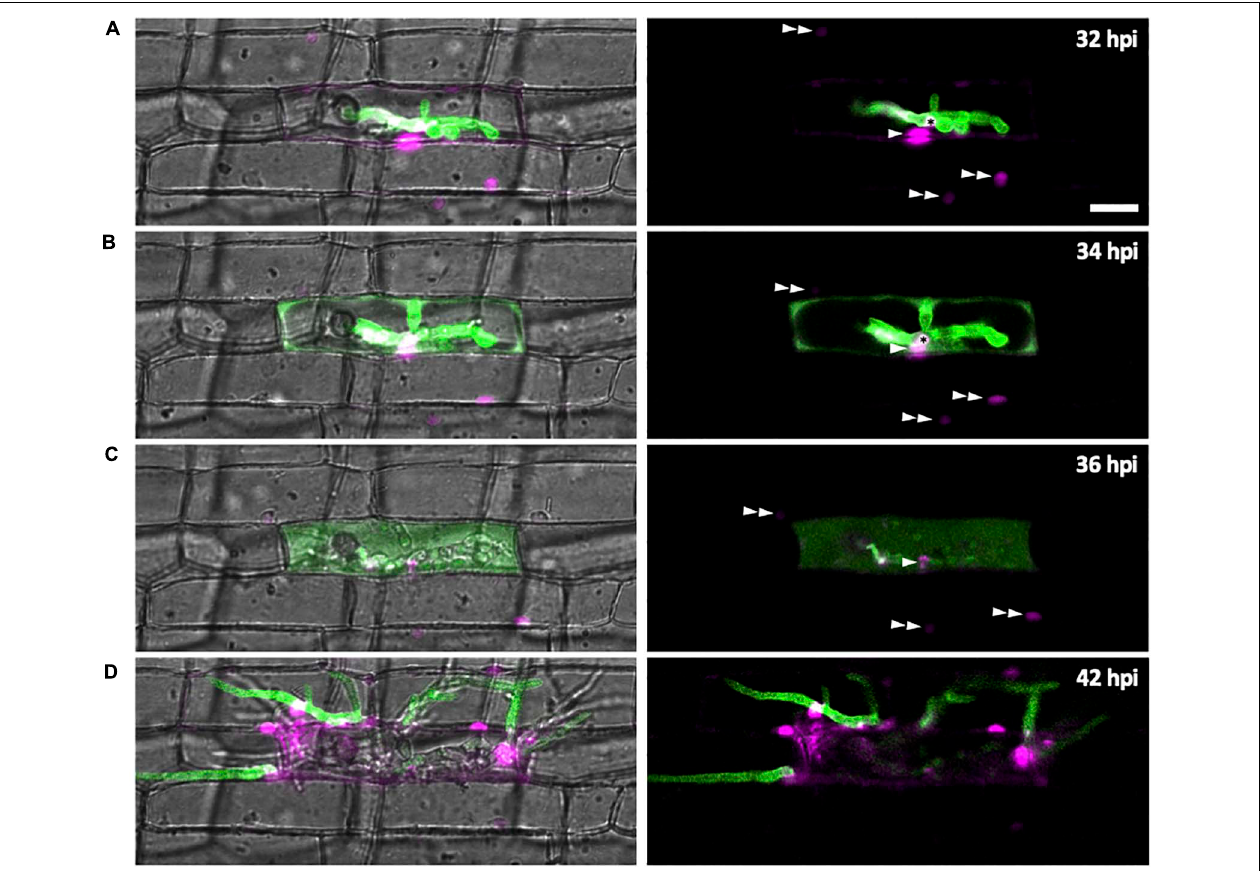
FIGURE 7 | Effector localization changes during invasion of the first few host cells. M. oryzae CKF1616 expressing apoplastic effector Bas4:EGFP (green) along with cytoplasmic effector Pwl2:mCherry:NLS (magenta) invading rice. Shown are single plane merged fluorescence and bright-field (left panels), and merged fluorescence alone (right panels) confocal images of a time-lapse series from 32 to 42 hpi. Asterisk = BIC. Single white arrowhead = first-invaded host cell nucleus with Pwl2:mCherry:NLS fluorescence. Double white arrowhead = nuclei of uninvaded host cells with Pwl2:mCherry:NLS fluorescence. (A) During the early stage of invasion, the EIHM was still intact, causing Bas4:EGFP to be retained within the EIHMx. Pwl2:mCherry:NLS was localized at the BIC, in the nucleus of the invaded cell, and in the nuclei of a few nearby cells. (B) The EIHM was disrupted, causing Bas4:EGFP to spill into the rice cytoplasm. (C) The vacuole ruptured, causing spilled Bas4:EGFP to homogenize throughout the host cell lumen. (D) IH invaded neighboring cells with Bas4:EGFP retained by new EIHMs. Pwl2:mCherry:NLS fluorescence increased upon invasion of neighboring host cells. By this time the first-invaded cell lacks significant levels of fluorescence. Bar = 20 µ